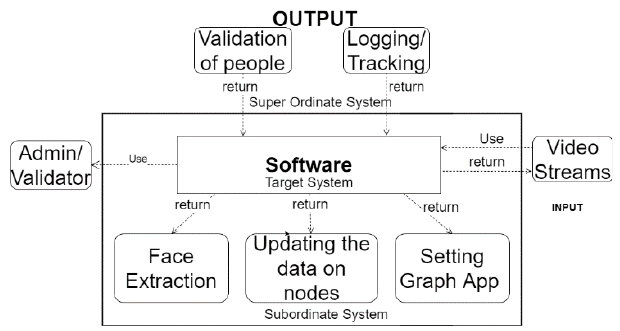
fig 2: basic architecture of the system where data is collected stored and